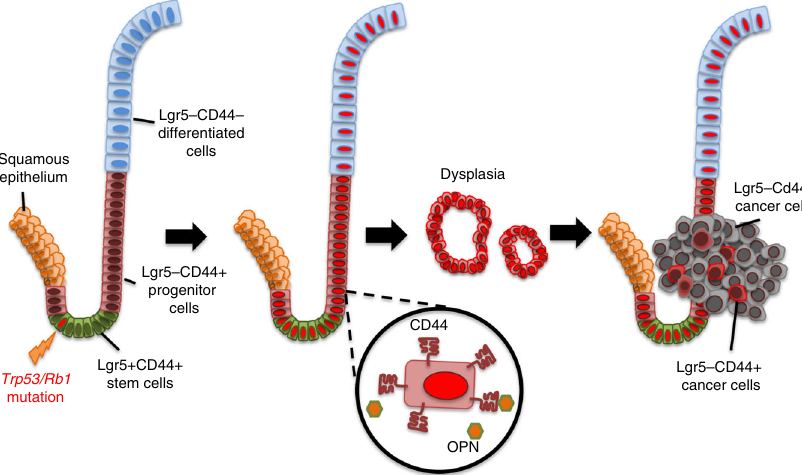
Fig. 7 Carcinogenesis at the gastric squamous-columnar